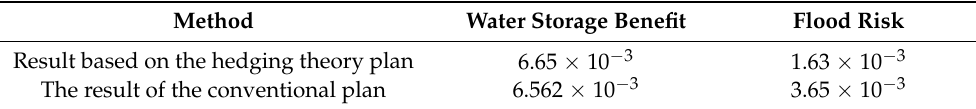
Table 3. Comparison of scheduling schemes based on hedging theory and conventional scheme.